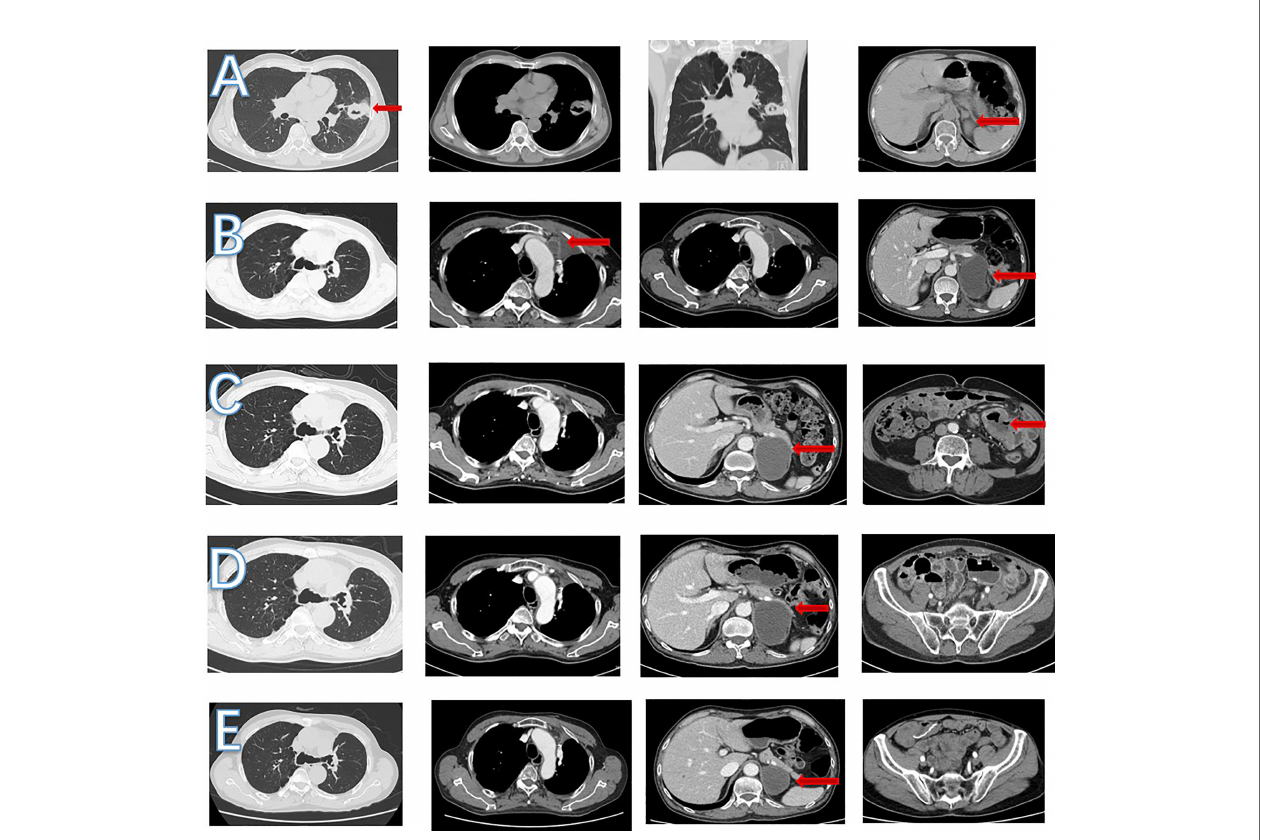
FIGURE 4 | CT scan images during treatment. (A) In June 2018, left lung nodules and suspected metastasis of left adrenal nodule. (B) In September 2018, enlarged mediastinal lymph nodule and increased left adrenal nodule. (C) In April 2020, a new small bowel mass was found, left adrenal nodule was stable and mediastinal lymph nodule shrank. (D) In July 2020, left adrenal and mediastinal lymph nodule was stable. No small intestinal tumor was found. (E) In March 2022, left adrenal nodule shrank and mediastinal lymph nodule was